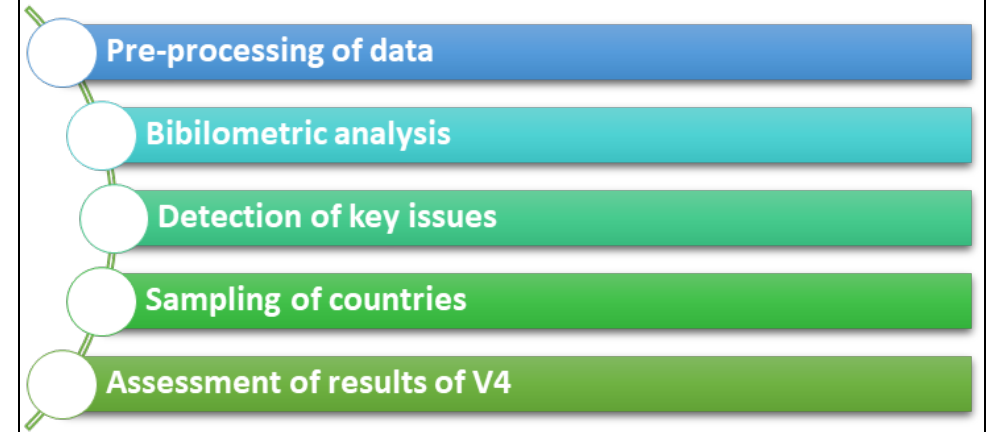
Figure 2. The methodological steps of the study. Source: own processing. 1.